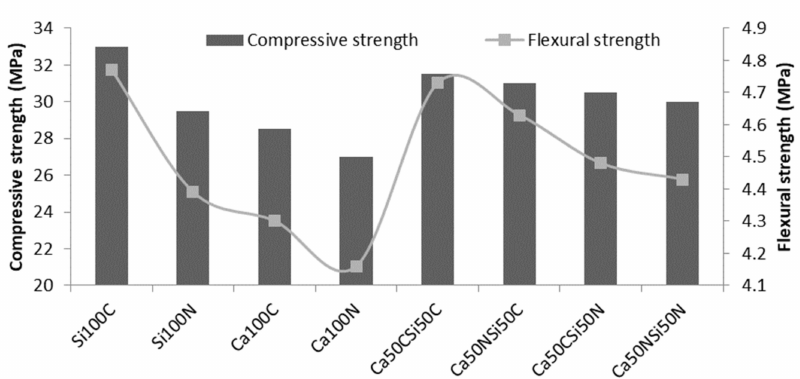
Figure 9. The compressive and flexural strength of